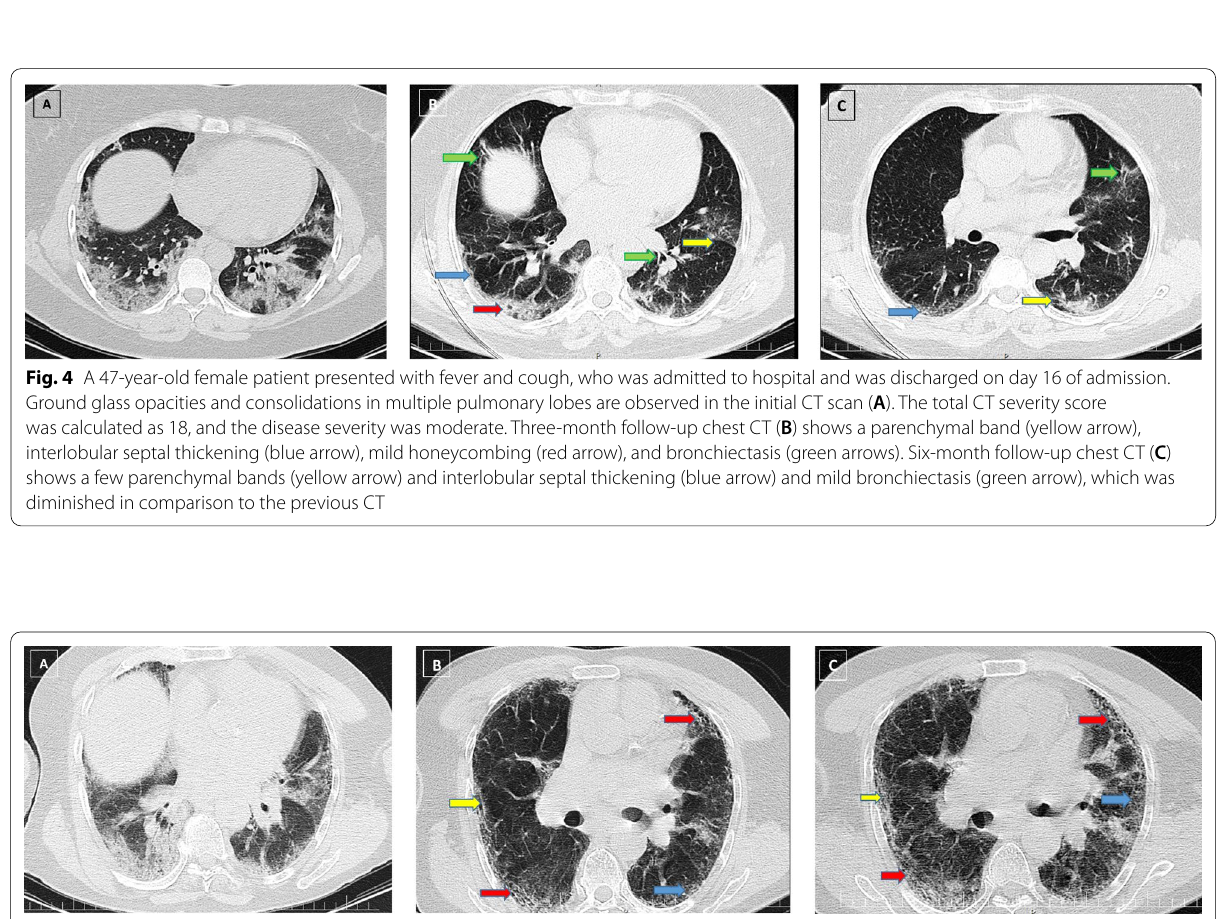
Fig. 5 A 70-year-old male patient presented with fever, chills, cough, and myalgia, who was admitted to hospital and was discharged on day 18 of admission. Ground glass opacities and consolidations in multiple pulmonary lobes are observed in the initial CT scan ( A ). The total CT severity score was calculated as 21, and the disease severity was moderate. Three-month follow-up chest CT ( B ) shows parenchymal bands (yellow arrow) and interlobular septal thickening (blue arrow) and honeycombing (red arrow). Six-month follow-up chest CT ( C ) shows parenchymal bands (yellow arrow) and interlobular septal thickening (blue arrow) and honeycombing (red arrow) as